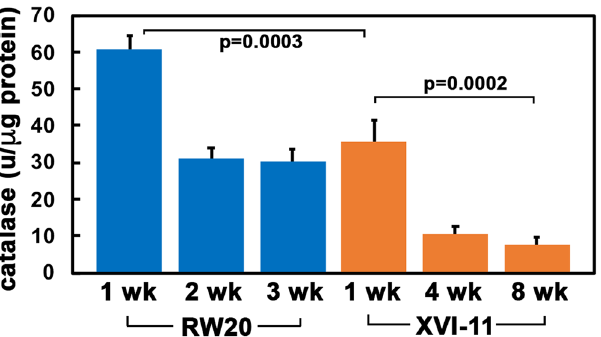
Figure 7. Comparison of catalase activity in RW20 and XVI-11. Catalase activity was determined using a previously published protocol based upon the extinction of hydrogen peroxide over a period of time. All reactions were performed in a 96 well plate that was read on a BioTek Plate reader at a wavelength of 240 nm using the Gen5 software that was included as part of the Bio-Tek plate reader. Plates were read every 47 s for a duration of 5 min and the extinction of hydrogen peroxide was calculated. The activity of catalase was then calculated based upon the slope of the line representing the disappearance of hydrogen peroxide. Blue corresponds to short-lived RW20 and orange corresponds to the long-lived XVI-11. Error bars indicate the standard error of the mean from 3 experiments and the p-values are as